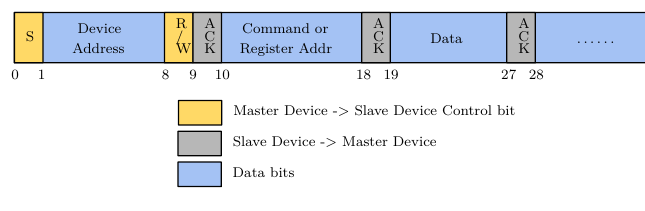
Figure 2: PMBus protocol structure